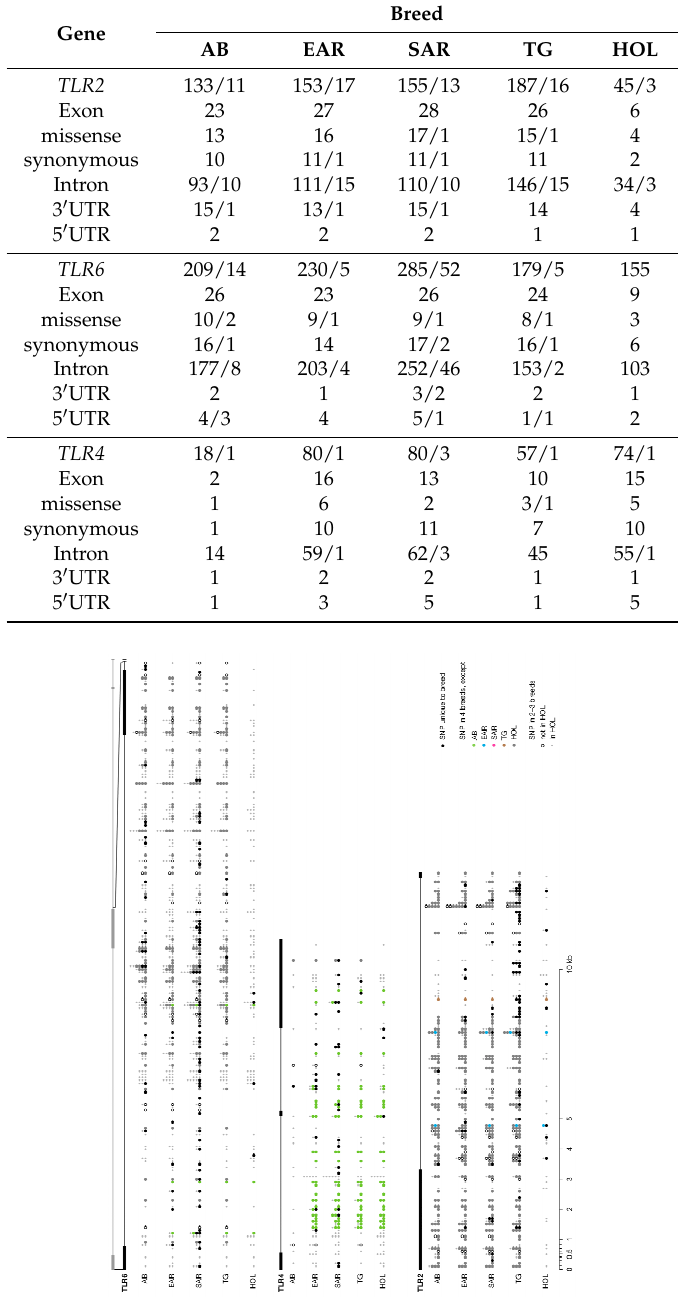
Figure 2. The location of SNPs in TLR6 , TLR4 and TLR2 in five breeds of cattle: AB, EAR, SAR, TG, and HOL. SNPs are shown by circles formatted to emphasize their potential interest. In decreasing order of interest: SNPs unique to a breed ( black ), SNPs found in all breeds except one (colored by breed), SNPs found in 2–3 breeds and not in HOL (hollow), SNPs found in 2–3 breeds including HOL (small grey circle). Only the first two exons and first intron for TLR6 are